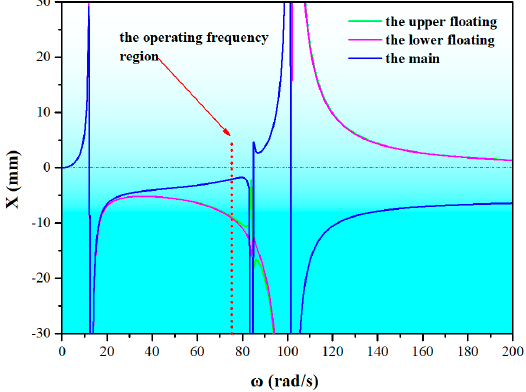
Figure 8. Amplitude-frequency characteristic curves in the x direction. Figure 8. Amplitude − frequency characteristic curves in the x direction. When ω < ω 01 , the amplitude X in the x direction of the floating screen frames and the main screen frame increased with the ω . At ω 01 = 12.80 rad/s, the maximum values of X were − 120.45, − 120.25 and − 117.38 mm. When ω 01 < ω < ω 02 , the amplitudes of the floating screen frames first decreased rapidly and then increased slowly. When ω increased to ω 02 = 84.15 rad/s, the maximum values of X were − 18.18 and − 15.91 mm. The amplitude of the main screen frame decreased rapidly at first and decreased slowly with an increase in the ω at ω 02 = 84.15 rad/s. The maximum value of X was − 100.9 mm. At ω 02 < ω < ω 03 , the amplitudes of the three screen frames increased rapidly with an increase in the ω , showing an inverse-phase characteristic compared to the floating screen frames. At ω 03 = 101.36 rad/s, the maximum values of X were − 1269.70, − 1238.89 and − 236.46 mm. At ω > ω 03 , the amplitudes of the screen frames decreased rapidly with an increase in the ω , (more than 120 rad/s), decreased slowly until X approached X = 1 and − 6 mm, and the main screen frame showed antiphase characteristics with the floating screen